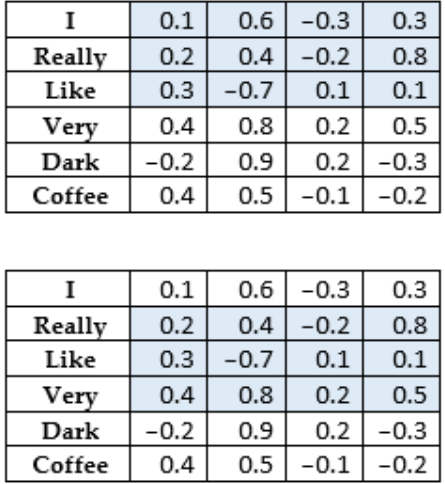
Figure 4. An example of the convolutional operation in text processing. The 1D convolution with the length “ window ” = 3 is illustrated.